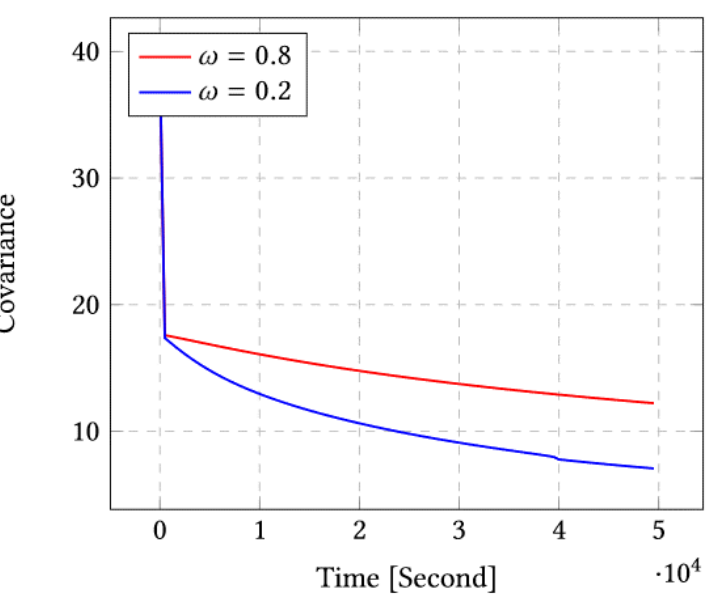
Figure 3. Covariance for ω = 0.8 and ω = 0.2 for the case of 10 sensors.